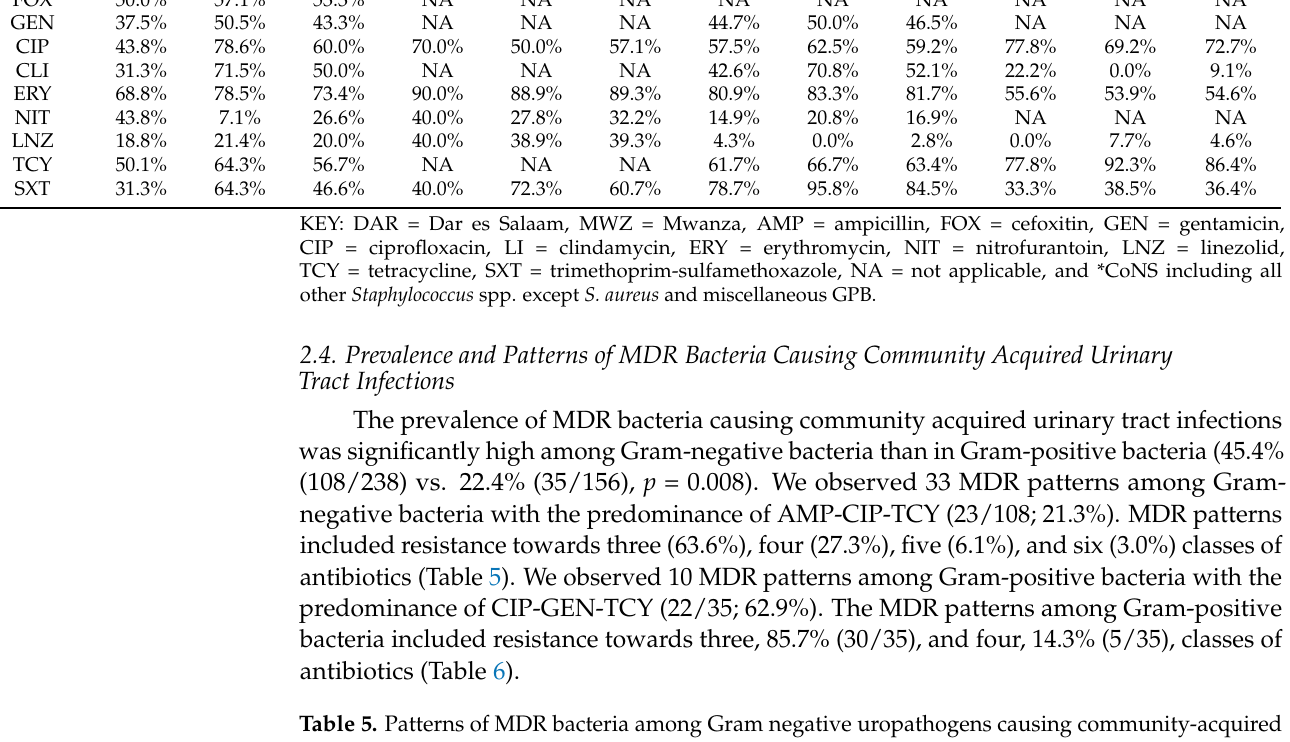
Table 5. Patterns of MDR bacteria among Gram negative uropathogens causing community-acquired urinary tract infections in